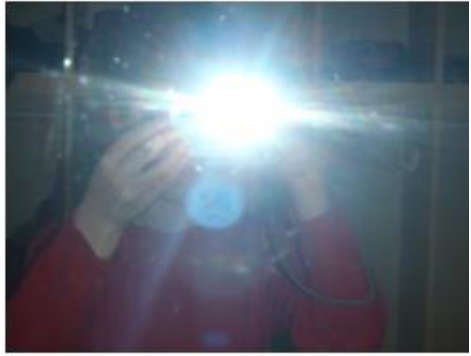
Figure 4. I bring myself a happy